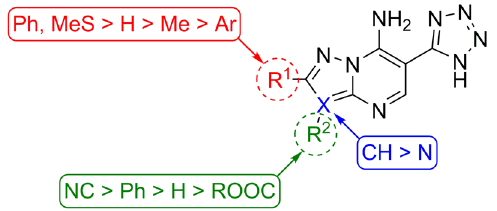
Figure 4. Structure-activity relationship for 6-(tetrazol-5-yl)azolo[1,5- a ]pyrimidines as CK2 inhibi- tors.